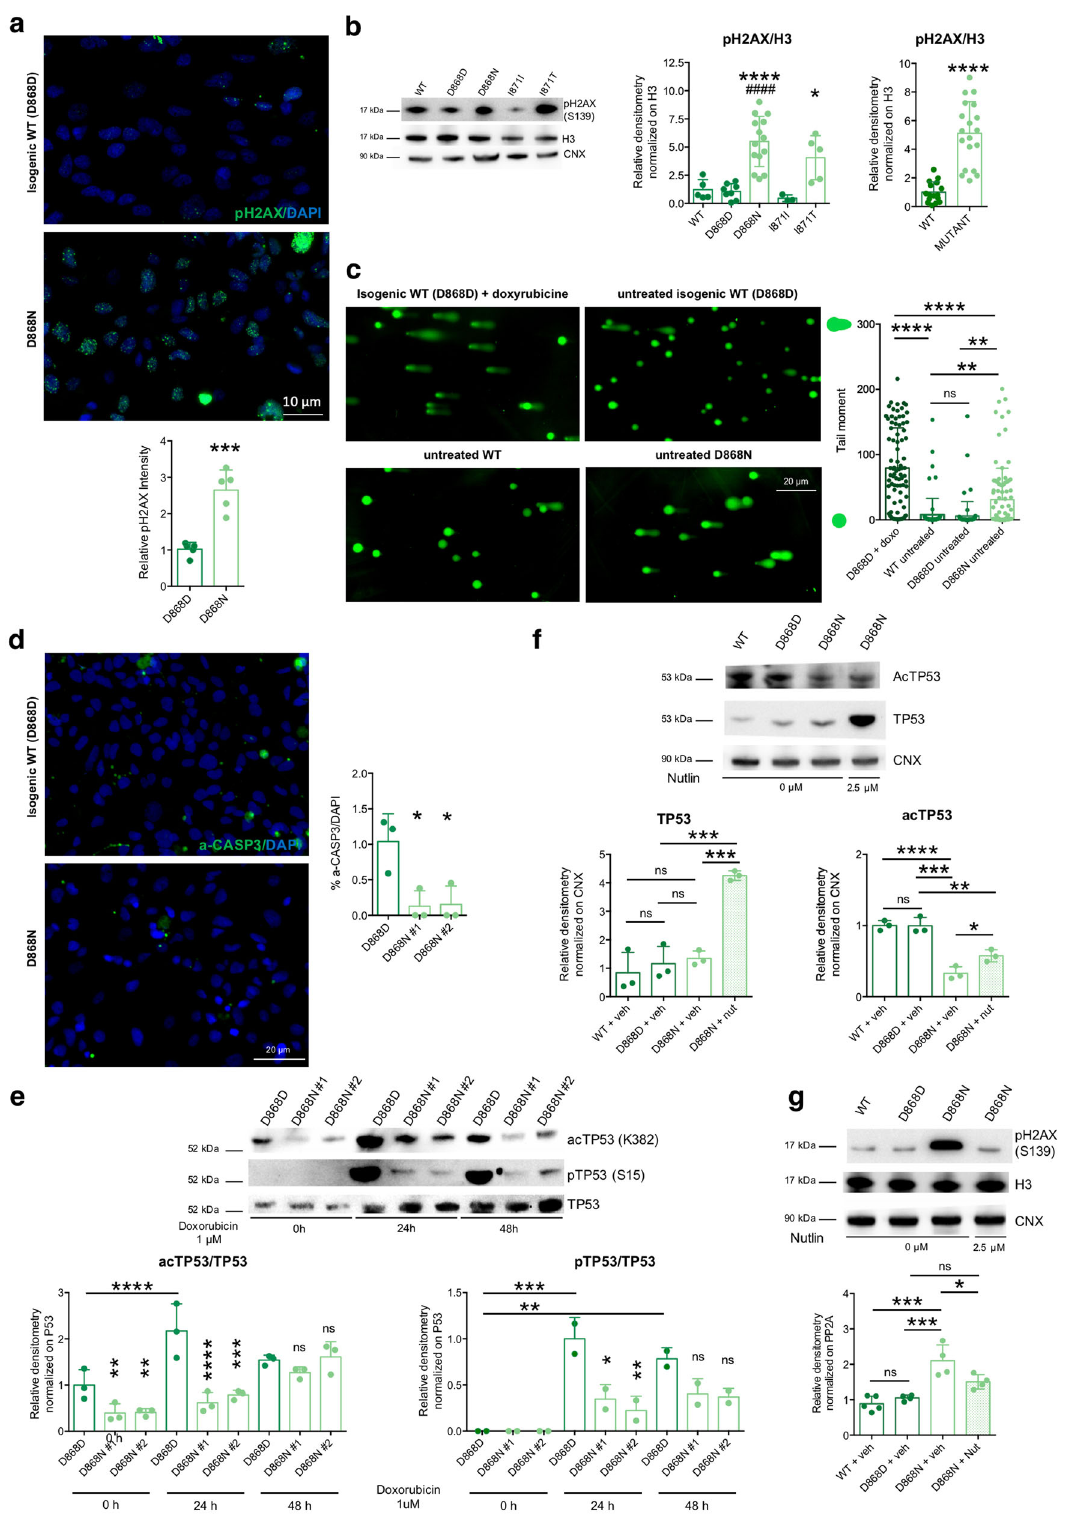
accumulated DNA damage may be the cause of genotoxic stress into intrinsically vulnerable cells as postmitotic neurons, thus possibly explaining the neurodegeneration occurring in SGS patients. To experimentally tackle this eventuality, we assessed cell death in postmitotic neuronal cultures by combining PI live staining with subsequent MAP2 immunostaining. Interestingly, dying neurons were more represented in SGS than in control cell